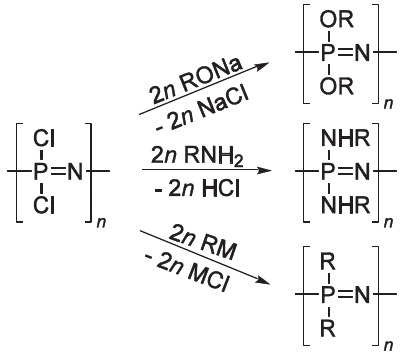
Figure 66. Some substitution reactions to yield useful